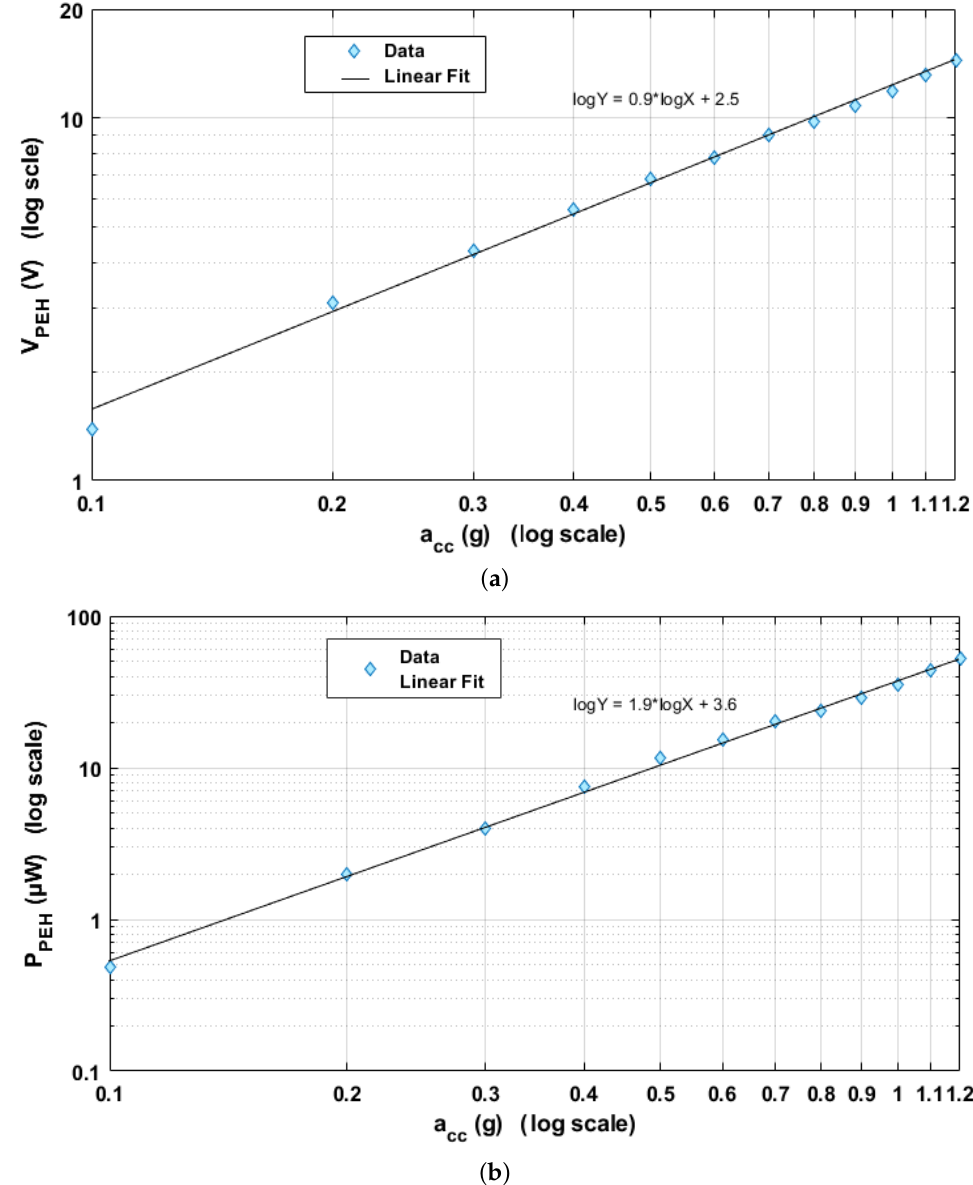
Figure 4. PEH experimental characterization as a function of acceleration a cc : ( a ) Open-circuit voltage V oc in volts vs. acceleration a cc in g in log scale; ( b ) PEH generated power P PEH in µ W vs. acceleration a cc in g in log